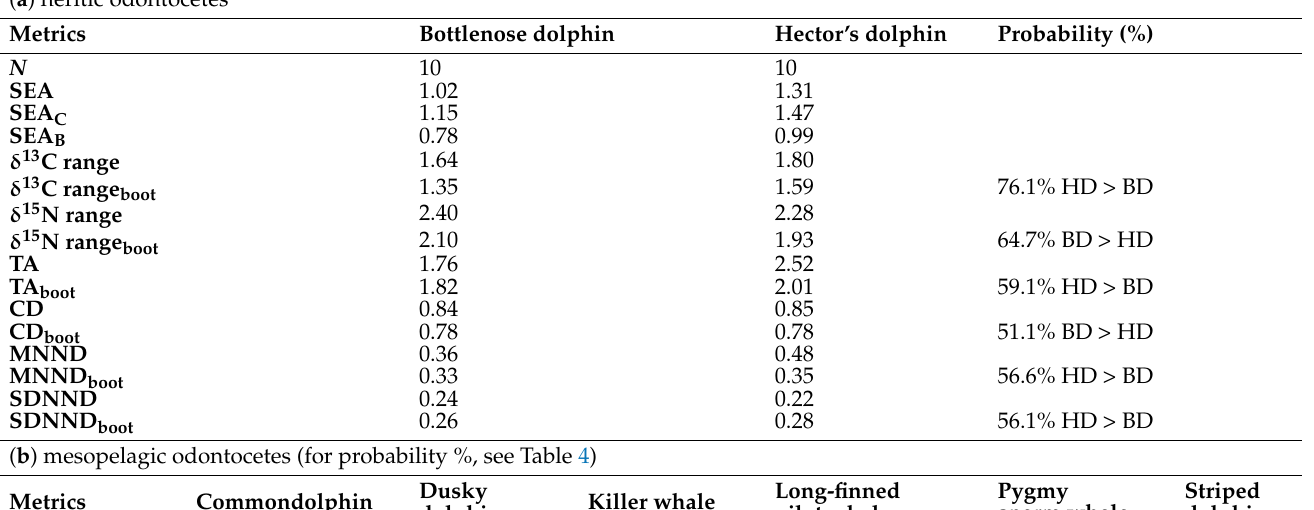
Table 3. Isotopic niche metrics (including the six Layman metrics) for adult odontocetes with n ≥ 10. SEA = standard ellipse area, SEA C = standard ellipse area corrected for small sample size, SEA B = Bayesian SEA, TA = total area, CD = mean distance to centroid, MNND = mean nearest neighbour distance, SDNND = standard deviation of nearest neighbour distance, see supplementary material for metric definitions. The subscript ‘boot’ indicates that the value (mean) has been generated via bootstrapping. Probability refers to the probability of the respective bootstrapped metric being larger in one species over another across all